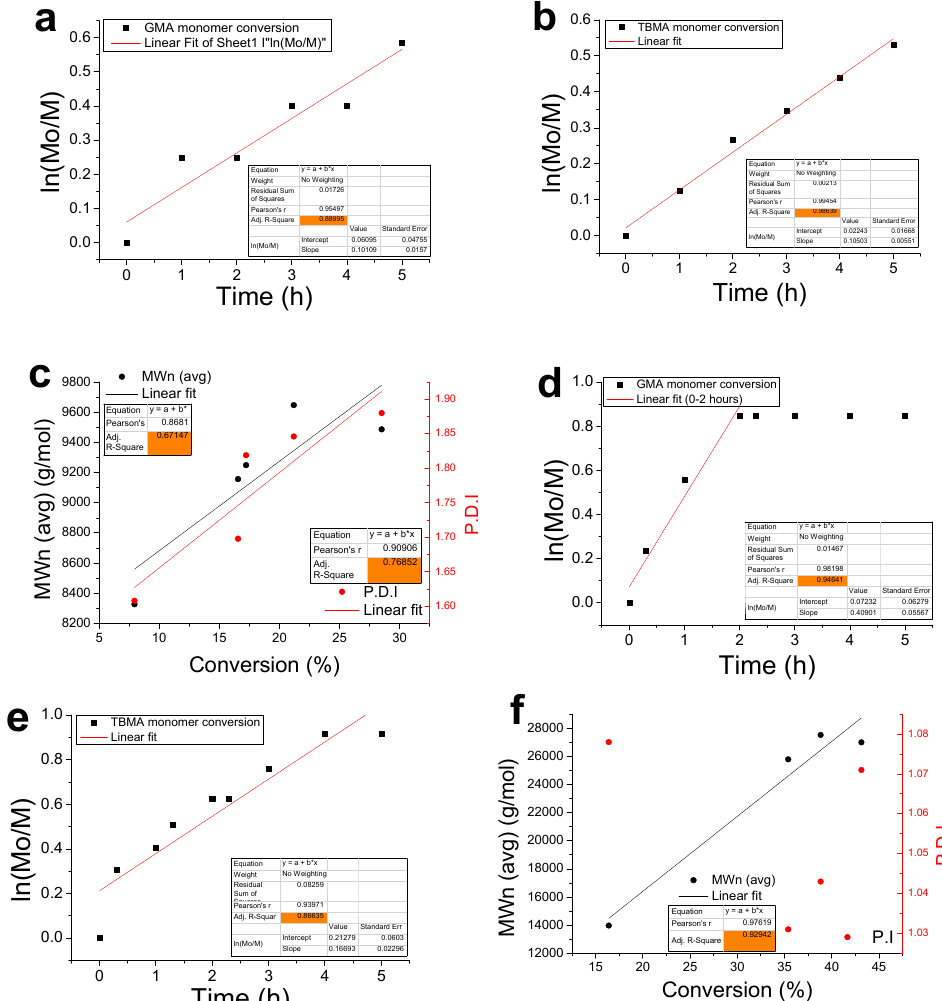
Figure 3. Kinetic plots of: GMA conversion ( a ), tBMA conversion ( b ) and polydispersity index and Mn ( c ) for terpolymer TP9; kinetic plot of GMA conversion ( d ), tBMA conversion ( e ) and polydispersity index and Mn ( f ) for terpolymer TP11.